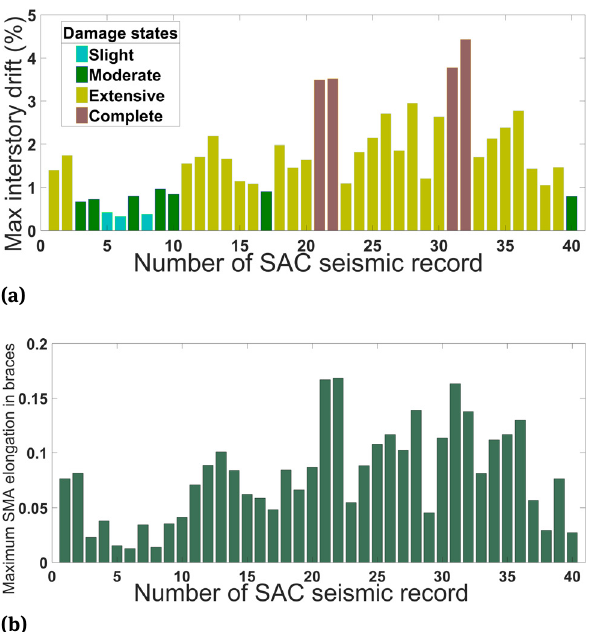
Figure 11: (a) Performance level of three-story optimized frame subjected to 40 ground motions; (b) Maximum elongation of SMA segments of three-story optimized frame subjected to 40 ground motions.